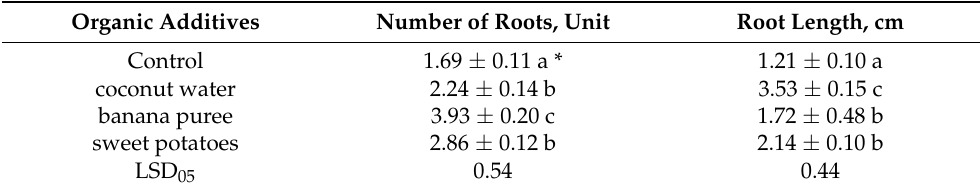
Table 3. Effect of organic additives on in vitro rooting of C. erythrostylum plantlets at 180 days of in vitro growth.